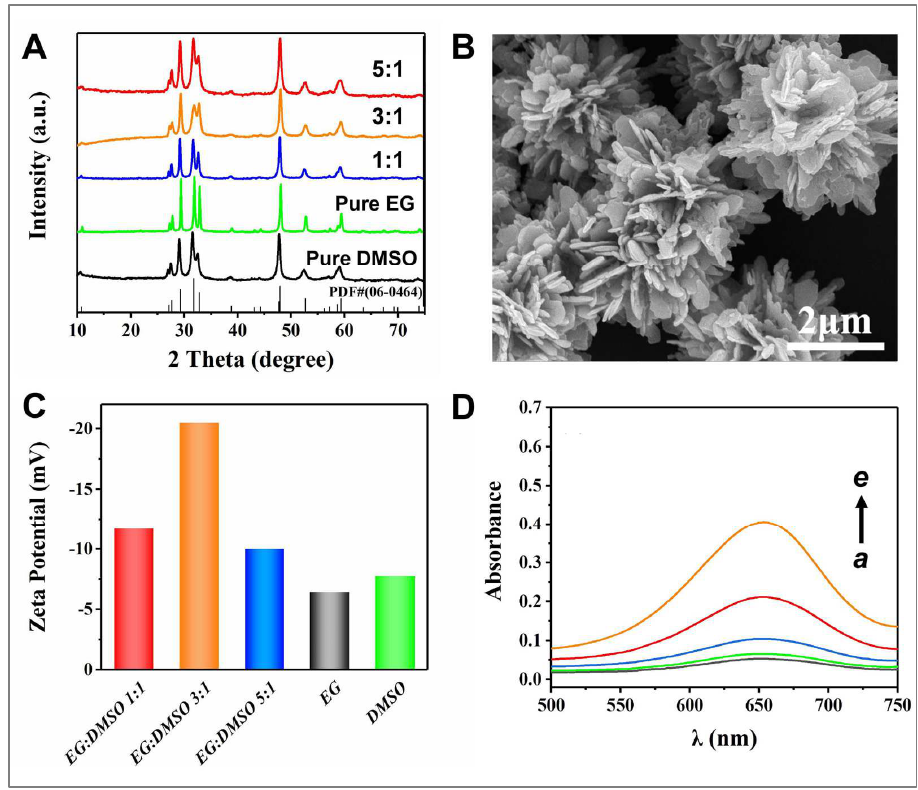
Figure 2. ( A ) The XRD patterns of the CuS synthesized by different solvent proportions; ( B ) The SEM image of the CuS synthesized by EG and DMSO with solvent ratio of 3:1; ( C ) The zeta potential of the CuS synthesized by different solvent proportions; ( D ) The absorbance signals produced by the CuS synthesized via different solvent proportions (line a–e: pure EG, pure DMSO, 5:1, 1:1,